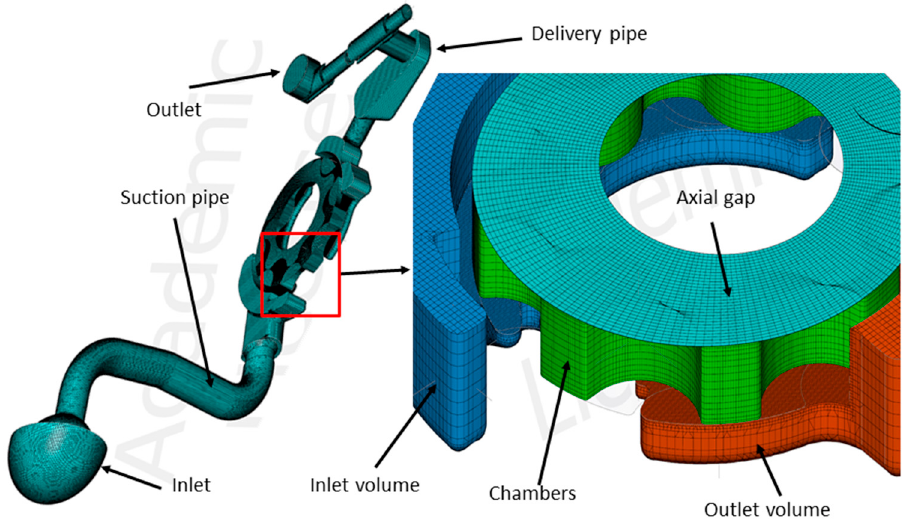
Figure 13. Model of a gerotor pump in PumpLinx with the detail of the rotary assembly